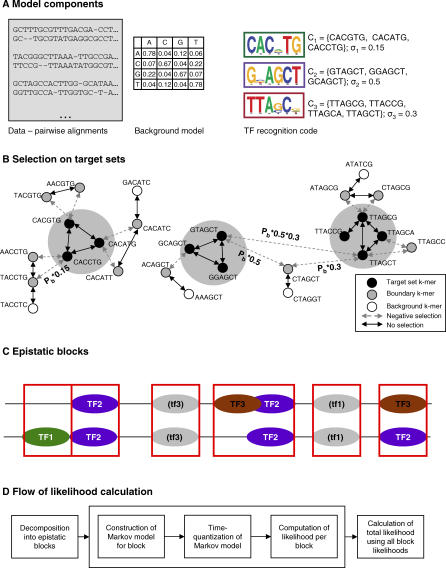
An Integrated Model for Evolution under the Effect of Multiple TFs(A) A TF recognition code. The TF recognition code model is defined by a set of target k-mer sets identified by specific TFs, and selection factors that quantify the intensity of selection on substitutions affecting them. In this example, the model consists of three target k-mer sets for three TFs. The background substitution probabilities are also part of the model.(B) Selection on k-mers. Substitutions between k-mers that belong to a target k-mer set (large grey circles) and k-mers that do not belong to that target k-mer set are under negative selection. The probability for that substitution is derived by multiplying the background probability by the appropriate selection factor(s).(C) Epistatic blocks. To compute the likelihood of a model given alignments, we first decompose the sequence into epistatic blocks that evolve almost independently of each other. Nontrivial epistatic blocks (marked by rectangles) include overlapping TFBSs or k-mers that are one substitution away from a target k-mer set (boundary k-mers). Ovals marked TFX represent a TFBS for TF X. Ovals marked (tfX) represent boundary k-mers for TF X. Loci that are not related to any TF form trivial epistatic blocks of size 1, and are not shown.(D) Scheme for computing likelihood. We approach the complex task of computing likelihood in our model by decomposing the sequence to epistatic blocks and computing likelihood inside each of them.